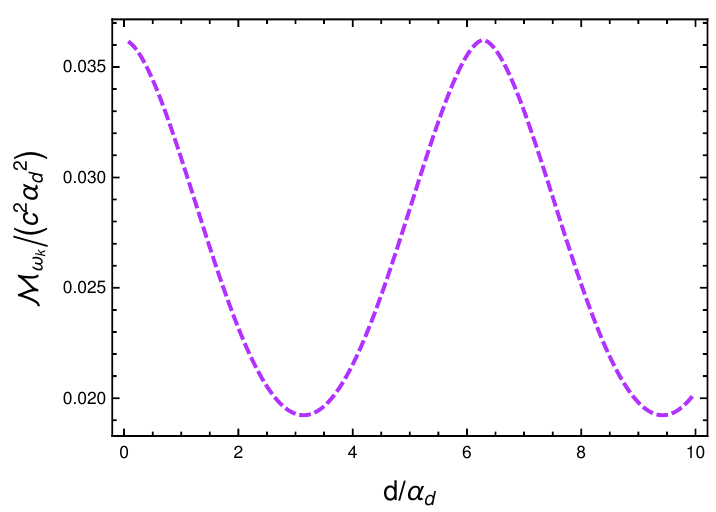
( ρ ) / ( c 2 r 2 ) perceived by two out going null detectors AB H k , for fixed transition frequency ∆ E = α ∆ E = 1 , d d = α = 1 , and α = ω 2 . k d ω k d k x k / and ∆ E when d/α = 1 . k d = 0 . Furthermore, d and this fact is graphically d